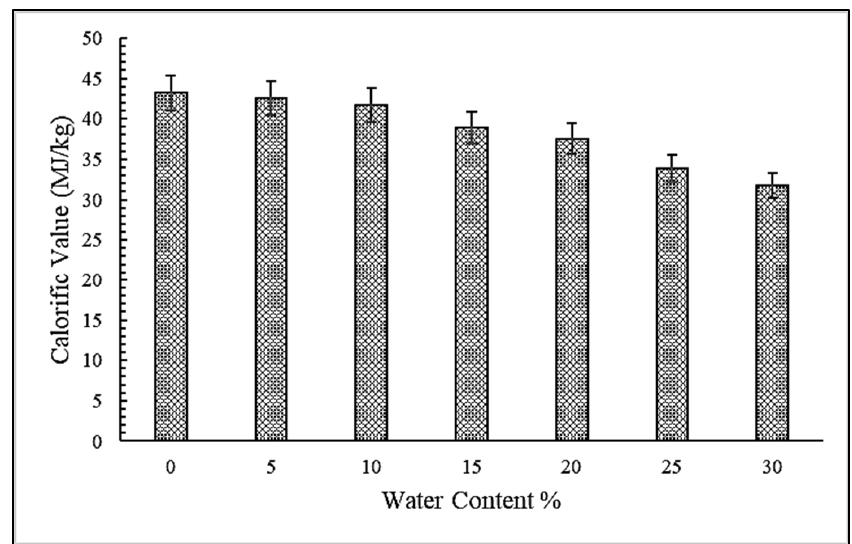
Figure 6. The viscosity of different blends of the (W/D) fuel.